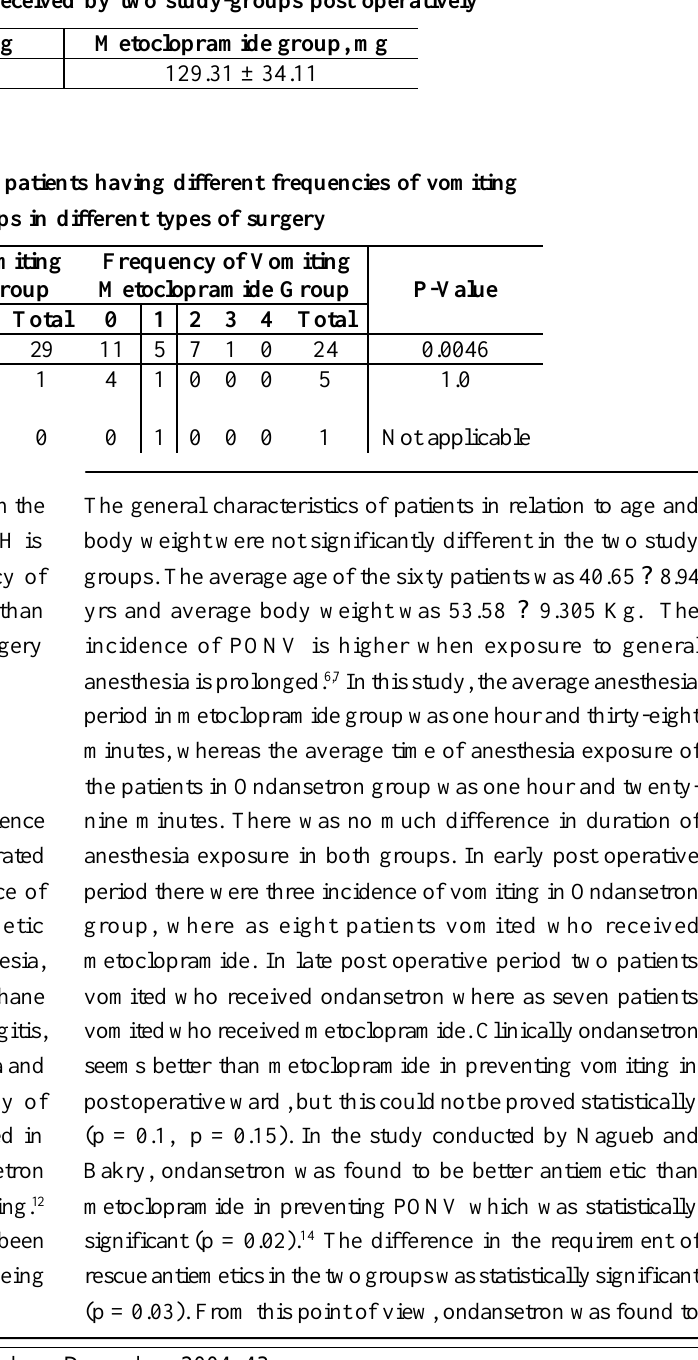
t=-0.125, p=0.90 Table IV : Average Diclofenac received by two study-groups post operatively